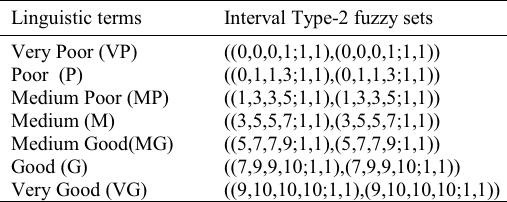
Linguistic terms